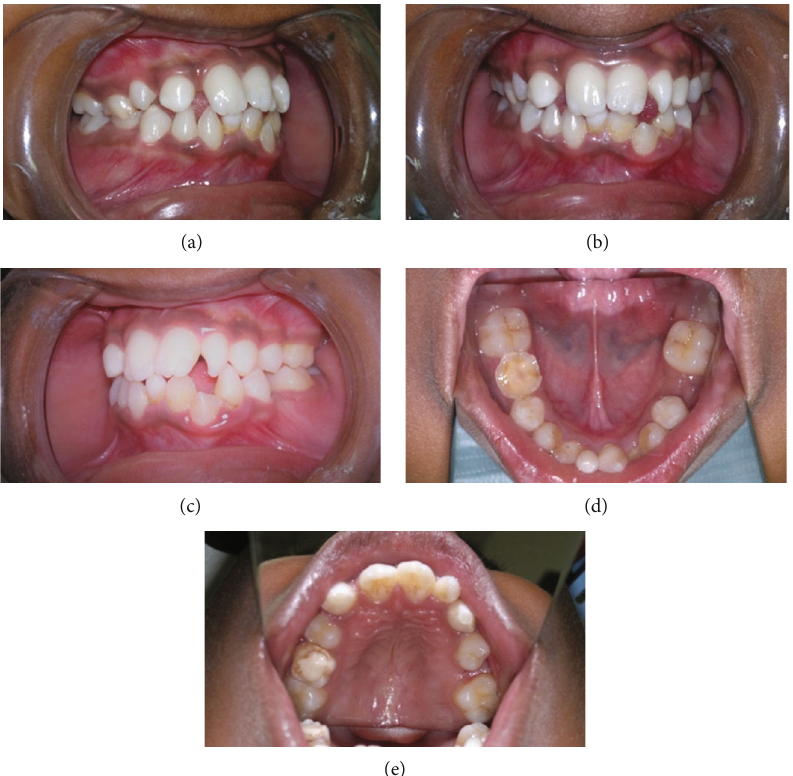
Figure 3: Preoperative intraoral images of (a) right buccal, (b) closed mouth, (c) left buccal, (d) lower arch, and (e) upper arch views.